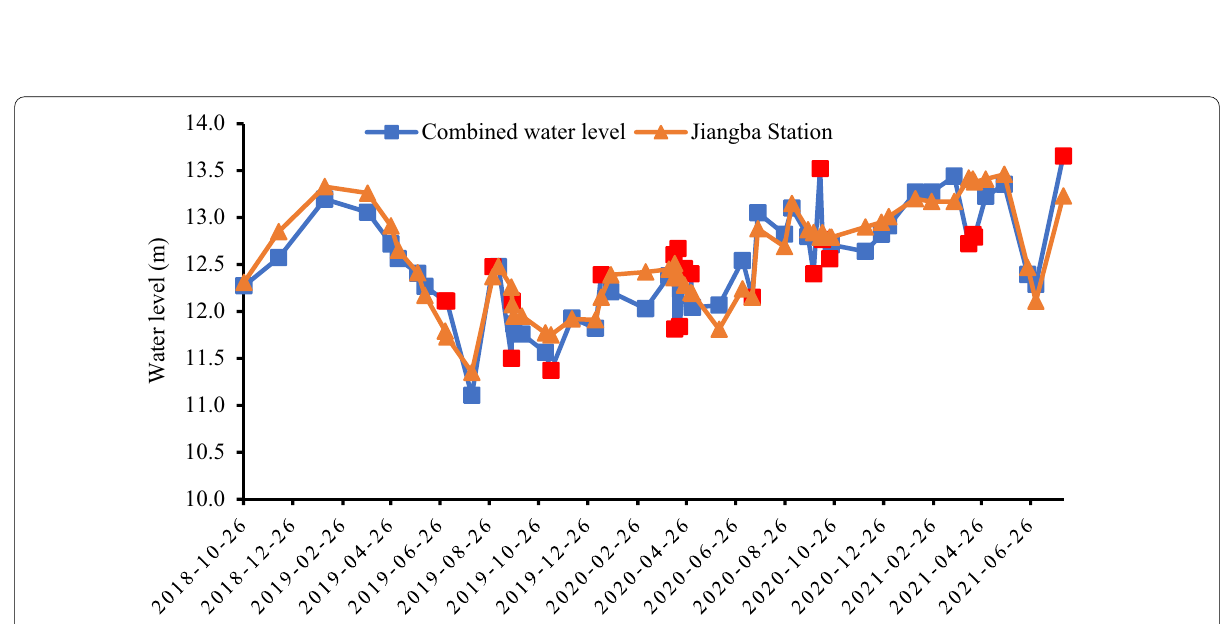
Fig. 6 Water levels retrieved by combining ICESat-2 (the blue squares) and adjusted GEDI (the red squares) for Hongze